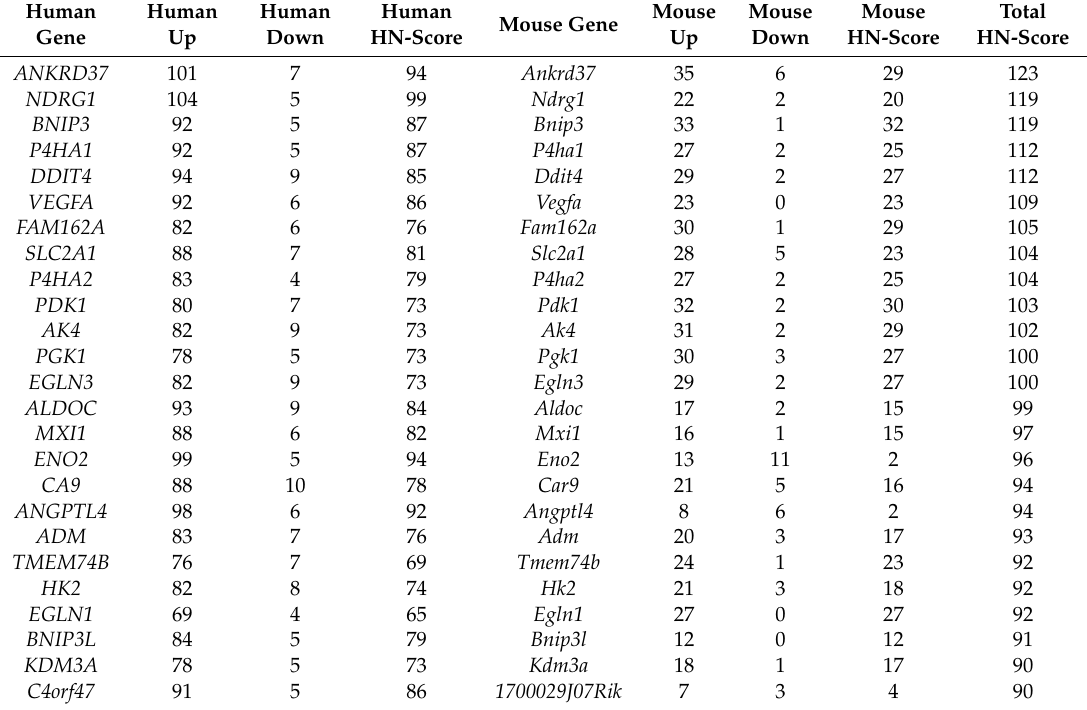
Table 1. List of top 25 hypoxia inducible genes. Top 25 genes with high hypoxia-and-normoxia-score (HN-score; human + mouse) with the number of paired samples that were judged as up-regulated and down-regulated after hypoxic stress. For the calculation of HN-score, see the